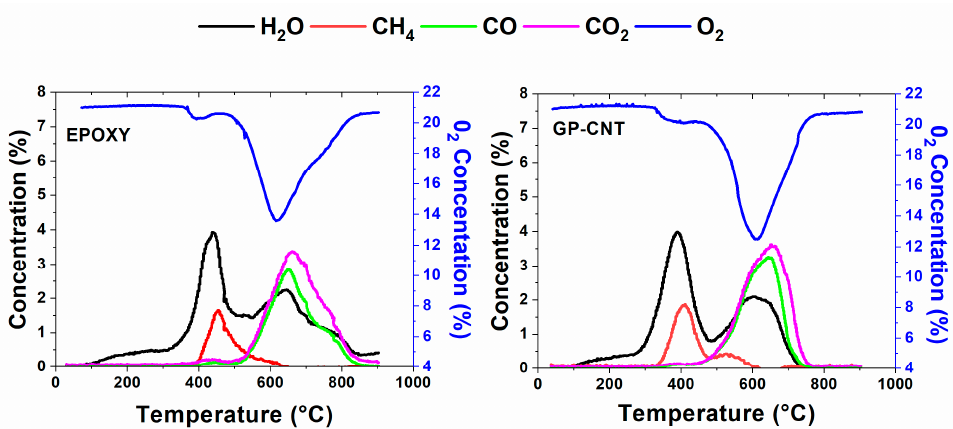
Figure 9. The oxygen consumed and gas released during oxidation in the temperature programmed oxidation (TPO) experiment. Table 4. Onset temperatures, temperatures at the peak, and offset temperatures for the concentration of the oxygen and for the released compounds during the combustion.